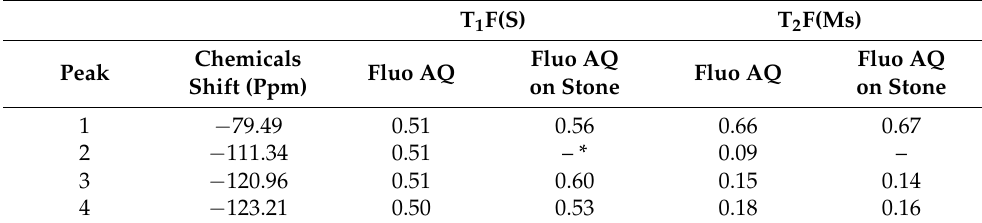
Table 8. T 1 F and T 2 F spin-lattice relaxation times of fluorine nuclei of Fluo AQ. T 1 F(S) Peak Fluo Shift (Ppm)